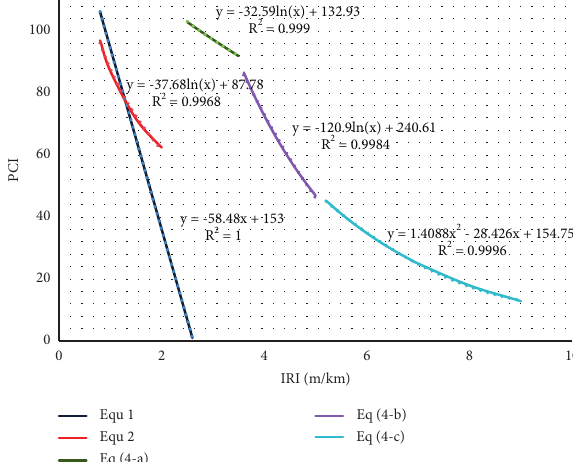
Figure 7: Comparison of equations (4a)–(4c) curve and equations (1) and